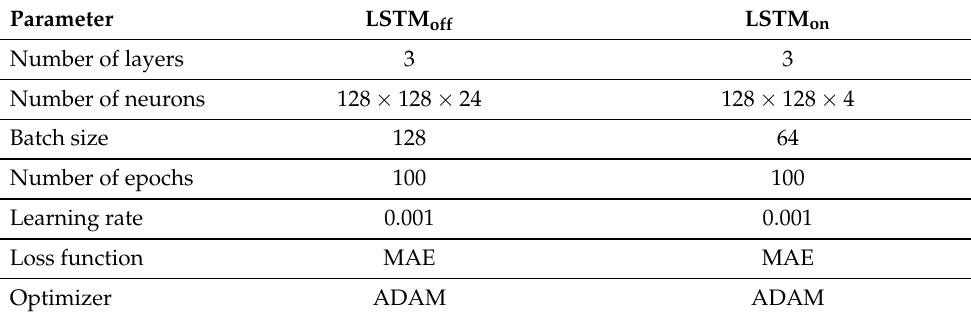
Table 1. LSTM Network parameters for training.